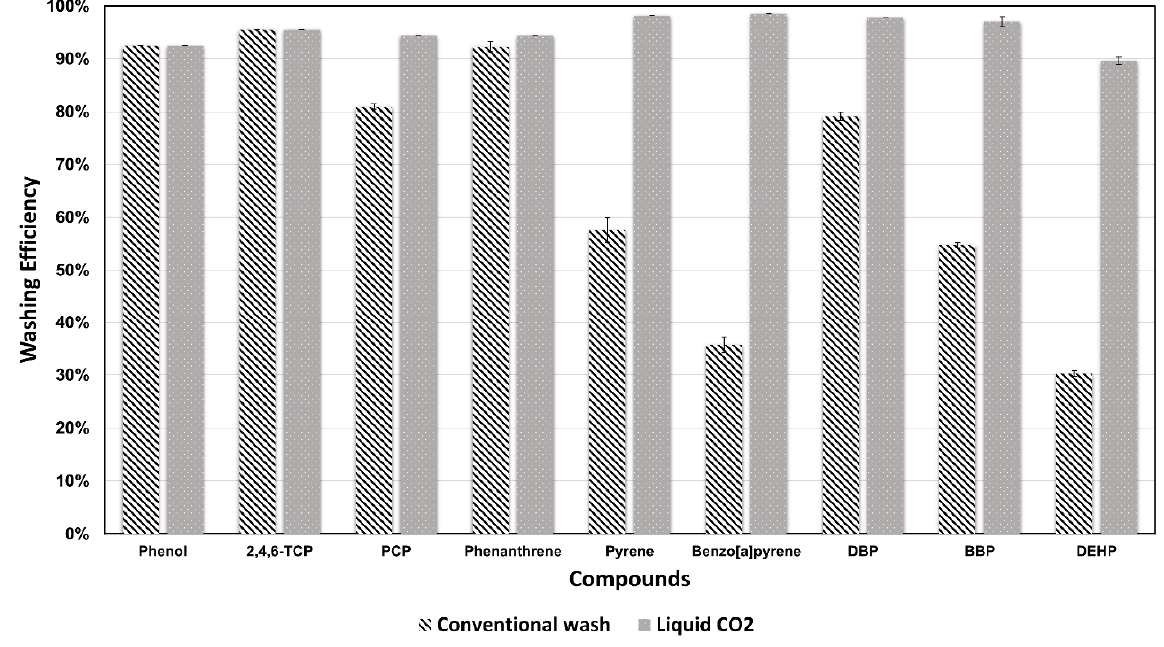
Figure 2. Comparison of washing efficiencies for conventional wash and liquid CO 2 . Table 5. Average washing efficiency of targeted contaminants for conventional and liquid CO 2.